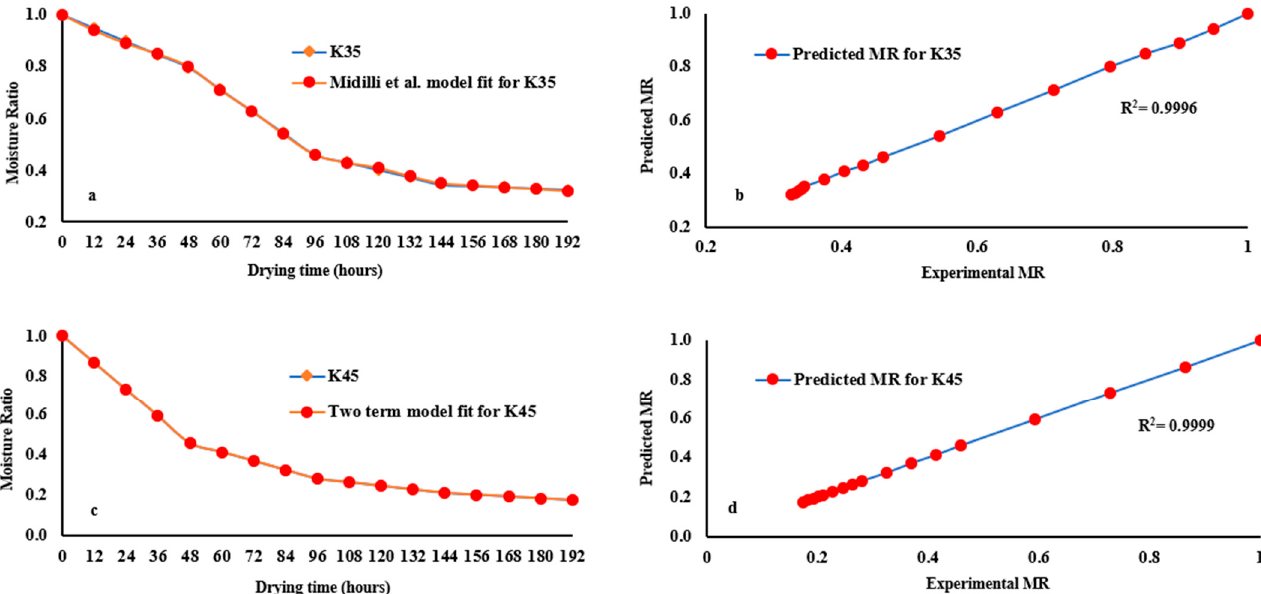
Figure 6. Experimental and predicted drying curves of K35 and K45 ( a – c ) and comparison of the experimental MR and predicted MR of K35 and K45 ( b – d ) using best-fit models. experimental MR and predicted MR of K35 and K45 ( b – d ) using best-fit